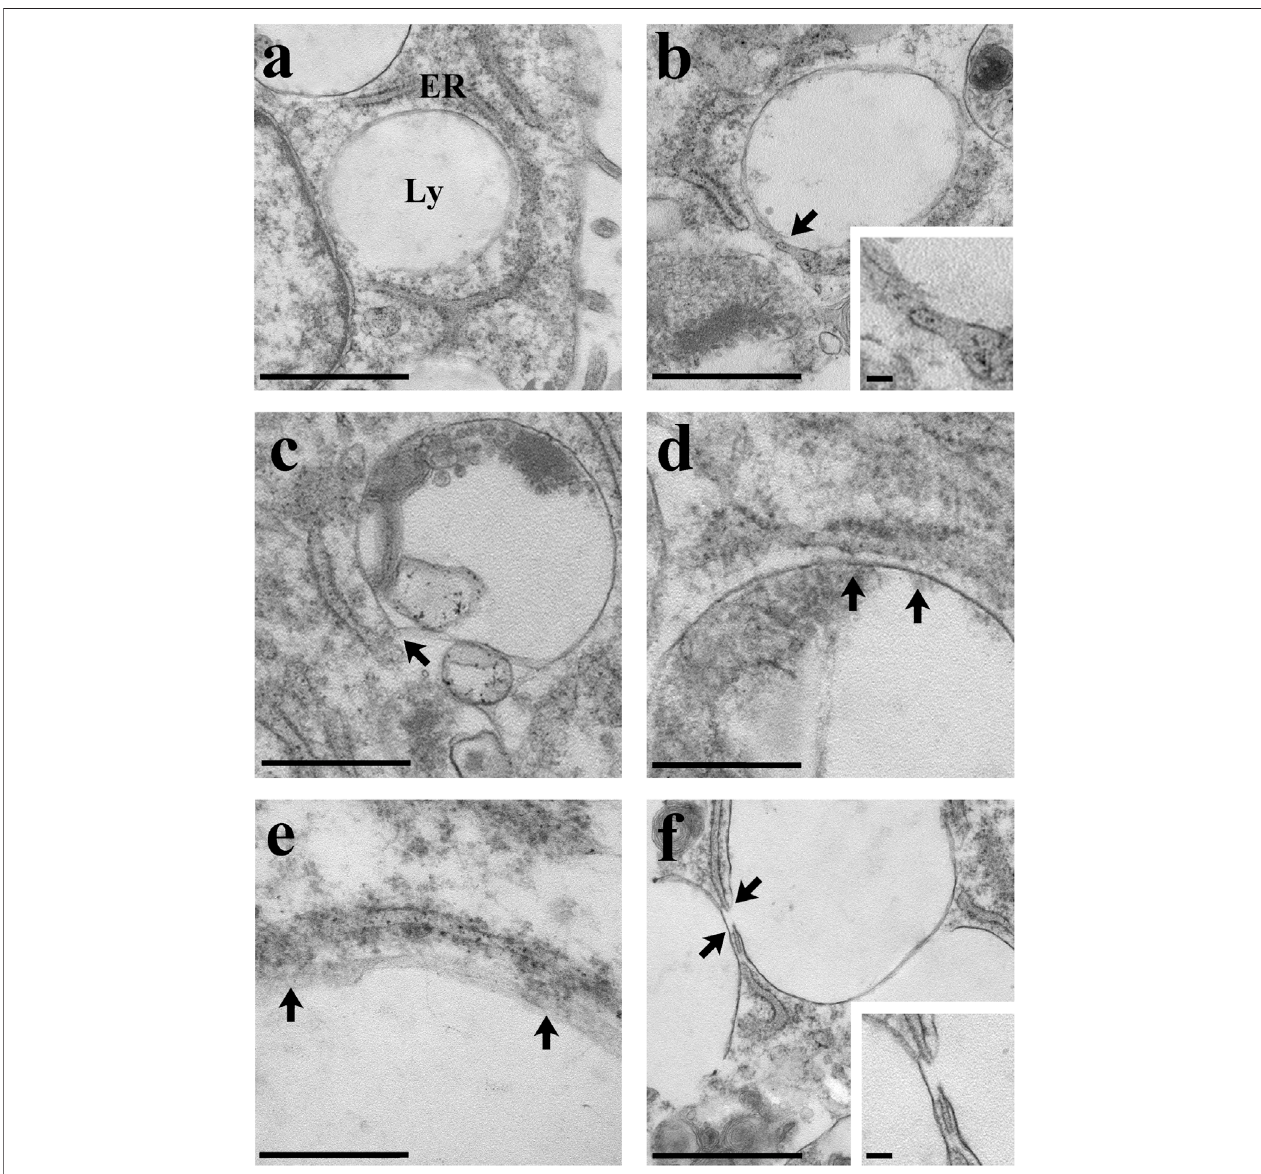
FIGURE4| UltrastructuralanalysisofC-MSCs.Severalexamplesofmembranecontactsbetweenlysosomes(Ly)andERareshown. (A) Notetheclosenessofthe lysosomes with the cell nucleus and ER. Scale bar: 1 µm. (B) The lysosome-ER contact site is indicated (arrow and inset). Scale bar: 1 μ m; inset scale bar: 100 nm. (C) The arrow indicates the membrane contact site. Scale bar: 500 nm. (D) Extensive contact (arrows) between the lysosomal and the ER membranes. Scale bar: 500 nm. (E) Notethecontact(arrows)betweentheribosomes-richERandthelysosome.Scalebar:200 nm. (F) Twocloselysosomes;theoneontherightisintightcontact with the ER (arrows and inset). Scale bar: 1 μ m; inset scale bar: 100 nm.